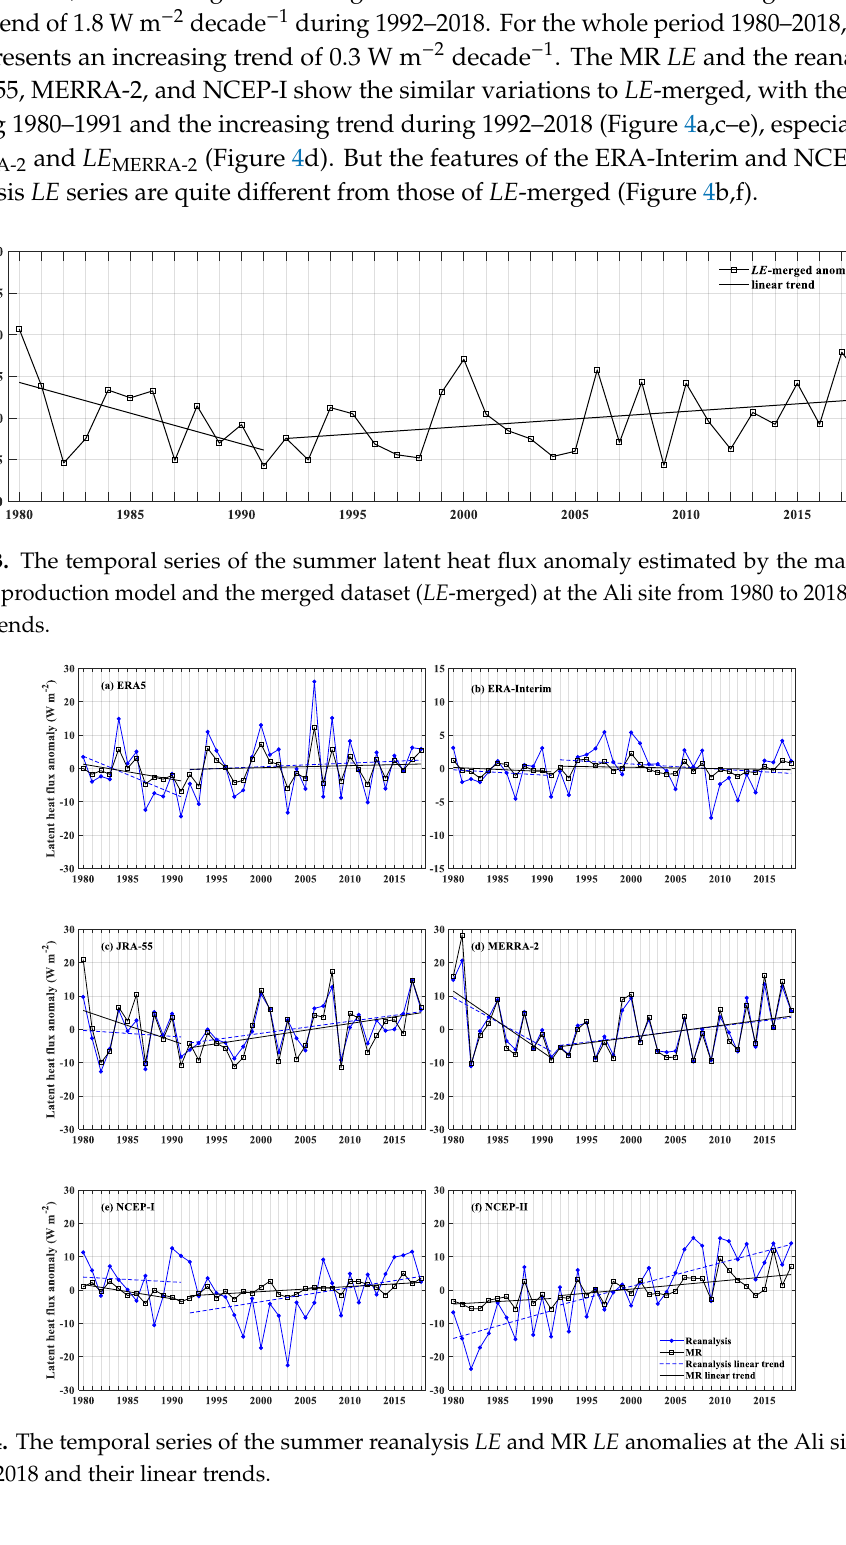
Figure 4. The temporal series of the summer reanalysis LE and MR LE anomalies at the Ali site from 1980 to 2018 and their linear trends. 4. Discussion Previous studies indicated that surface energy fluxes during summer are mainly affected by precipitation, especially in arid regions [30-32]. To explore the reasons for the difference in LE of the six reanalysis datasets, we analyzed the summer reanalysis precipitation. The varying features of the summer reanalysis precipitation are generally similar to that of the observed precipitation during 2014 – 2016, with the maximum precipitation occurring in July-August (Figure 5). However, the